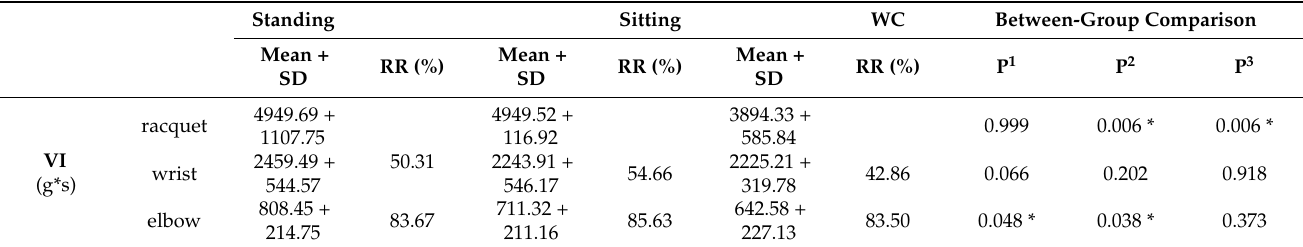
Table 7. Integration of vibration intensity (VI) of the racket (400 G), wrist (100 G), and elbow (25 G) for three